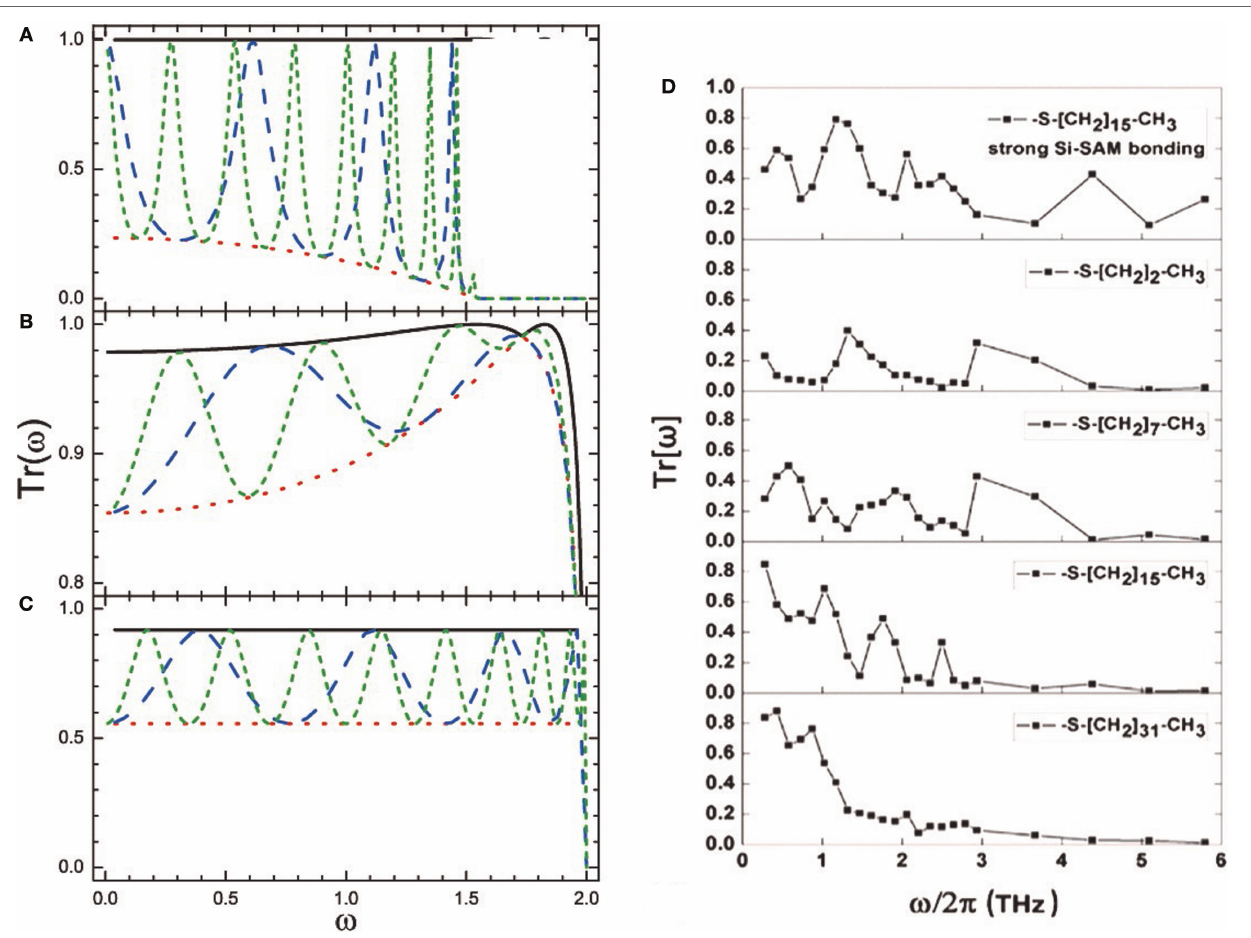
FIGURE 5 | (A–C) Transmission coefficient Tr [ ω ] as a function of frequency ω of two-junction atomic chains, which is adapted with permission from the copyright holder (American Physical Society), Zhang et al. (2011). (D) Transmission coefficient Tr [ ω ] as a function of frequency ω of the incident longitudinal acoustic wave packet for various self-assembled monolayer (SAM) thicknesses, adapted with permission from the copyright holder (American Physical Society), Hu et al.